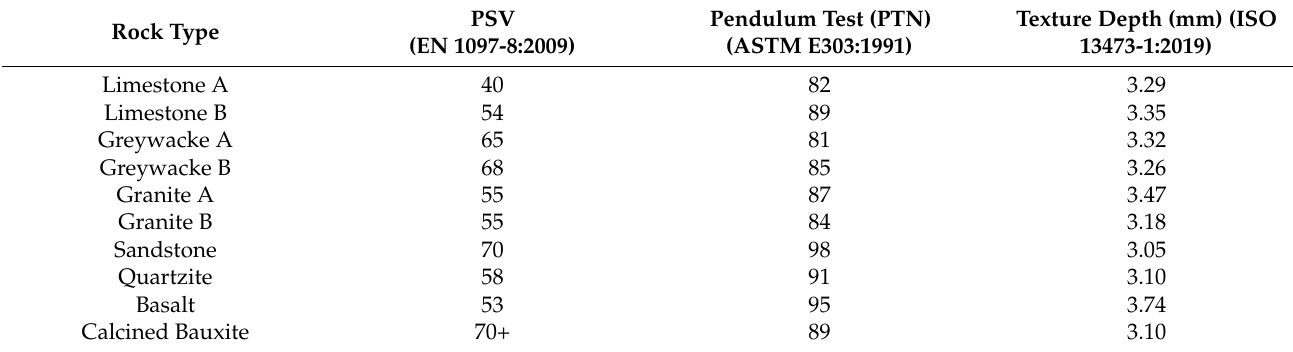
Figure 13. Possible development of friction over time for asphalt pavements (adapted from [76]). Table 2. Different types of natural aggregates used in high-friction mixtures, showing polished stone values (PSVs) and asphalt surface